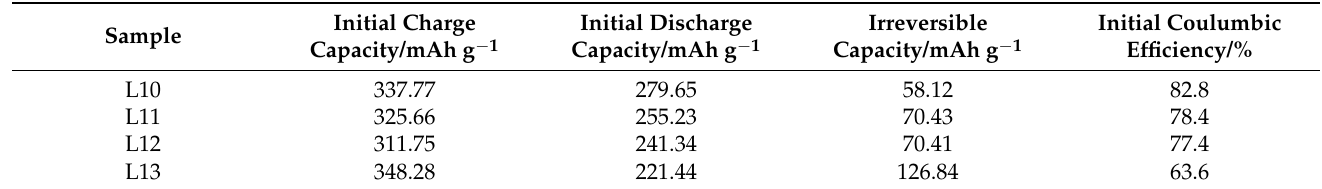
Figure 3. ( a ) Initial charge–discharge profiles of L10–L13 at 0.03 C within 2.0–4.8 V; ( b ) charge-dis- charge profiles of L10–L13 for the 31st cycle at 0.1C within 2.0–4.8 V; ( c ) Voltage profiles of L10–L13 for comparison of 3rd discharge and 31st discharge; ( d ) Voltage profiles of L10 for comparison of the 1st discharge, 3rd discharge and 31st discharge. Table 3. Initial charge–discharge performance of samples L10–L13 at 0.03 C within 2.0–4.8 V.